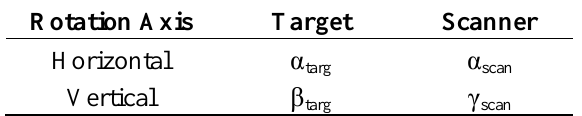
Table 1. Terminology for horizontal and vertical scanner and target rotations.